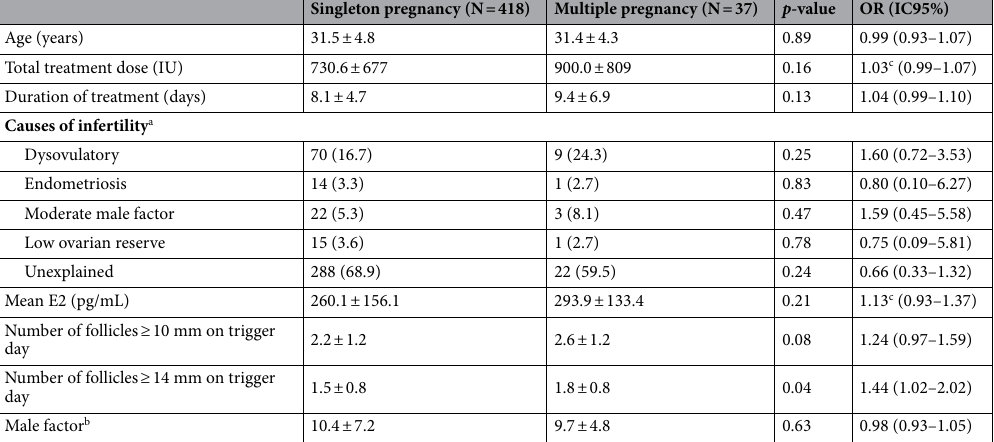
Table 3. Univariate analysis to assess the factors predictive of MP (GEE model). a Some couples could have had multiple causes of infertility. b Concentration of sperm with progressive motility (all > 3 × 10 6 /mL according to inclusion criteria. c Odds ratio was calculated for a variation of 100 units of the corresponding variable.